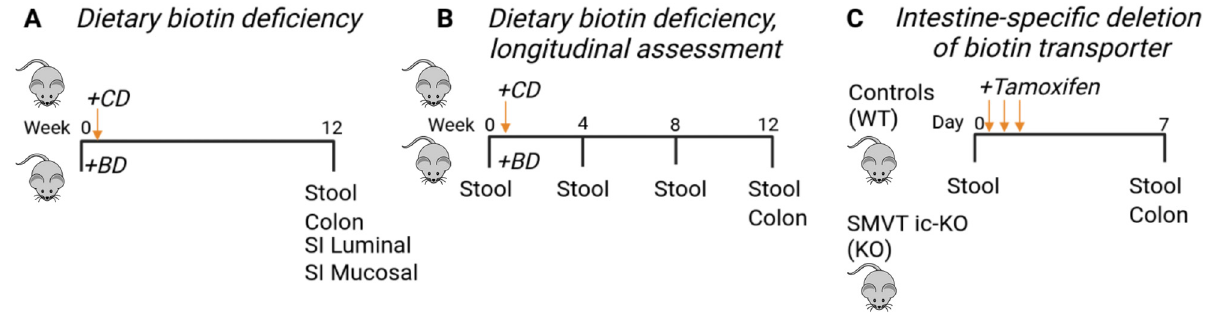
Figure 1. Study design and schematic illustrating the samples collected from the three experiments which were utilized for 16S rRNA gene sequencing. ( A ) Mice were placed on either a control diet (CD, n = 10) or biotin-deficient diet (BD, n = 7). At euthanasia, luminal and mucosal-adherent samples from the small intestine (SI), colon samples, and stool samples were collected for 16S rRNA amplicon sequencing. ( B ) Mice were placed on a CD ( n = 8) or BD ( n = 4). Baseline stool collected prior to the diet treatment, stool samples collected at weeks 4, 8, as well as stool and colon samples collected at Week 12, were utilized for microbiomics. ( C ) Baseline stool was collected from SMVT-icKO (KO, n = 4) or their littermate controls (WT, n = 4). Following tamoxifen treatment on Days 0, 1, and 2 to induce deletion of SMVT, stool and colonic samples were collected at Day 7 and utilized for microbiomics.